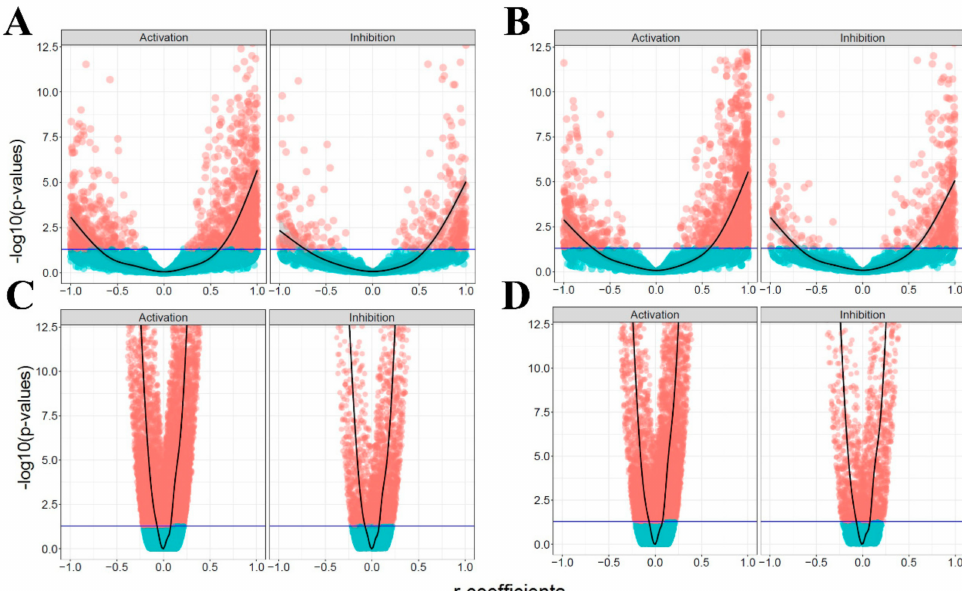
Figure 4. The volcano plots of the activation and inhibition edges. The horizontal axis is the Pearson correlation coe ffi cient, and the vertical axis shows log transformed False Discovery Rate (FDR)-adjusted p -values. The threshold line (blue) represents the significance cut-o ff value of 0.05. ( A – D ) plots correspond to KEGG / GEO, OmniPath / GEO, KEGG / GDSC, and OmniPath / GDSC analyses,